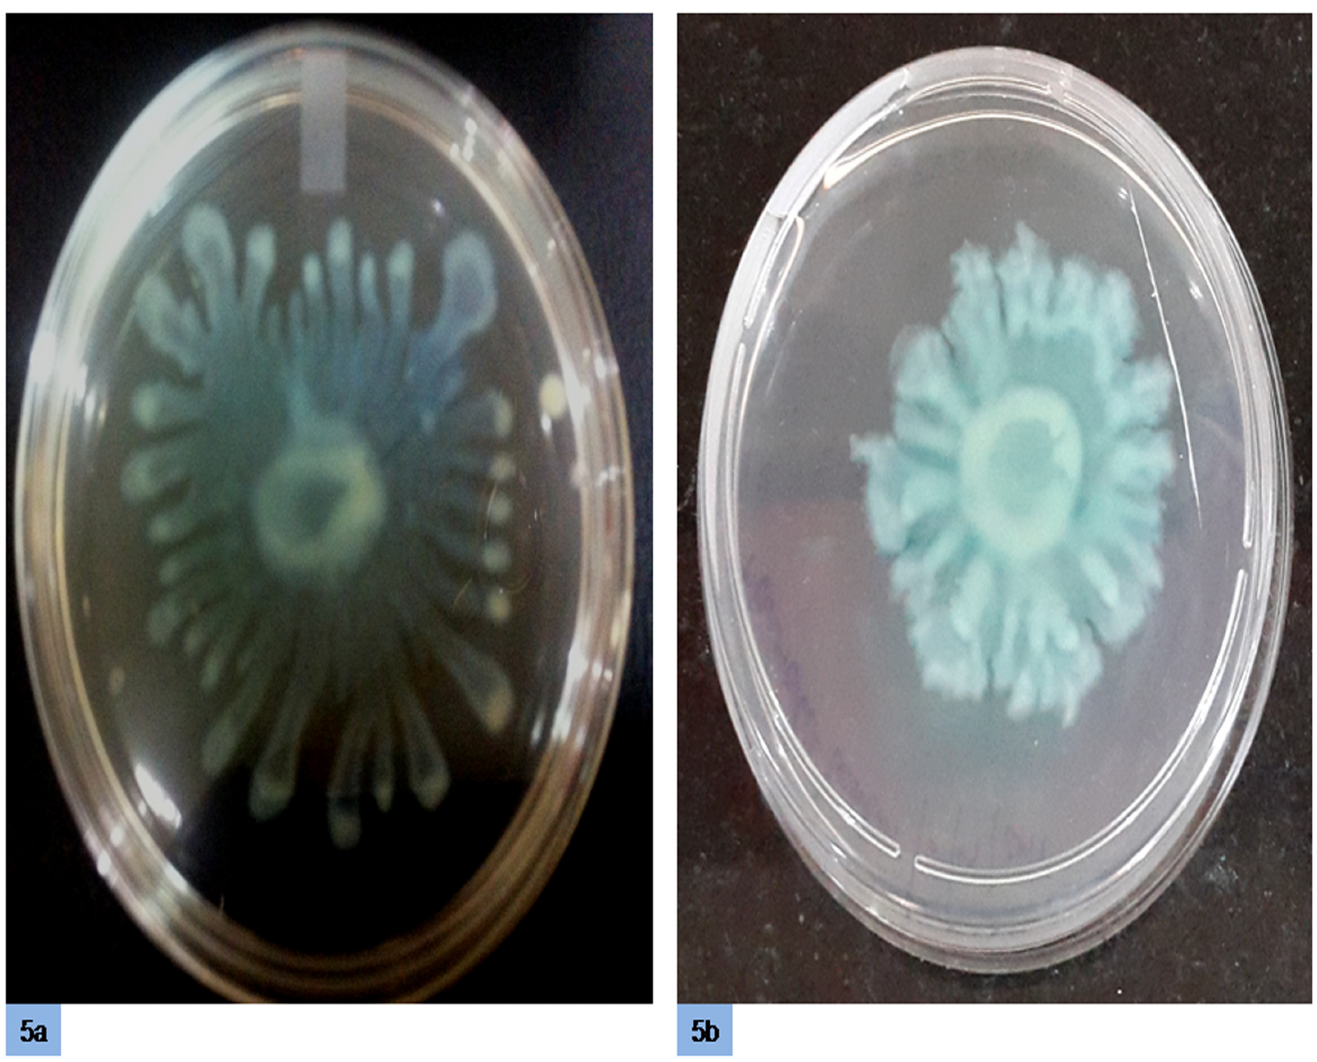
Fig 5. Swarming motility of P . aeruginosa PAO1. (a) Untreated (b) treated with 0.2 μ l/ml cinnamon